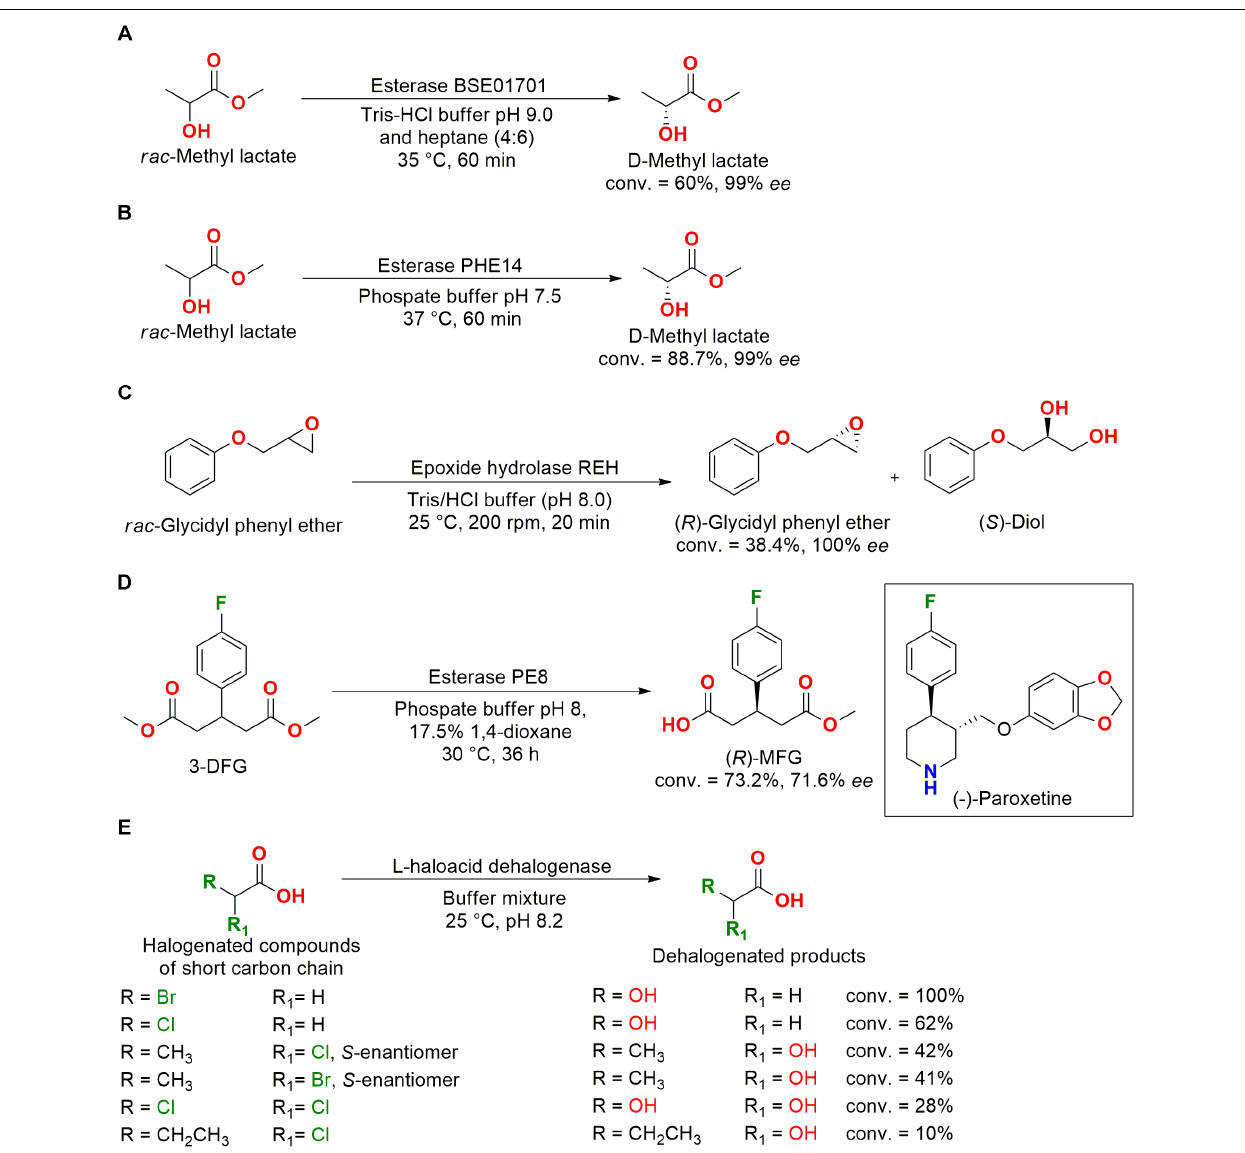
FIGURE 11 | Resolution for D -methyl lactate production by (A) esterase BSE01701 (Huang et al., 2016) and by (B) esterase PHE14 (Wang Y.L. et al., 2016). (C) Kinetic resolution of rac -glycidyl phenyl ether into the ( R )-enantiomer by the epoxide hydrolase REH (Woo et al., 2010). (D) Production of ( R )-3MFG, a precursor for (–)-paroxetine hydrochloride drug synthesis, employing the esterase PE8 (Wei et al., 2013). (E) Dehalogenation of monobromated carboxylic acids by the L -haloacid dehalogenase HADII BSW from Pseudoalteromonas sp. BSW20308 (Liao et al.,